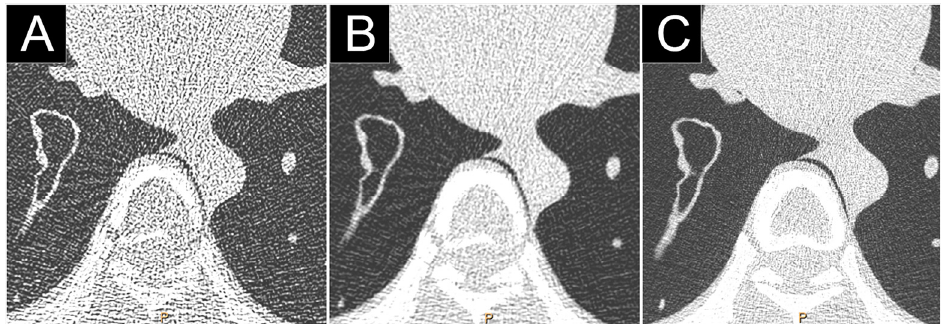
Figure 7. Comparison of high-resolution low dose lung imaging (120 kVp, 10 mAs) between a dual- layer EID-CT (iQon, Philips, Haifa, Israel; ( A ): filter YB, ( B ): filter F) and a clinical prototype PCD-CT (Philips; ( C ): filter detailed 1) in an anthropomorphic phantom CT Torso CTU-41 (Kyoto Kagaku, Tokyo, Japan). Both 1024 matrix and field-of-view of 350 mm were matched. Beam hardening was greatly reduced on the PCD-CT images, greatly improving the image quality.